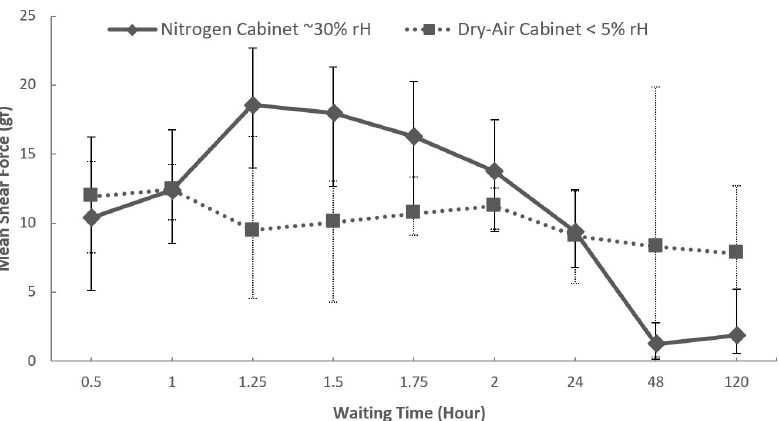
Figure 7. Shear force versus storage time for the samples stored in a nitrogen cabinet (solid curve) and in a dry-air cabinet (dashed curve). Each point presents a mean of at least 60 sheared balls from four different samples.